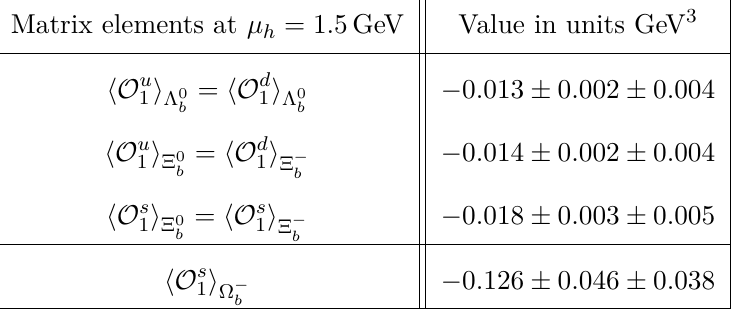
Table 4 . Numerical values for the matrix elements of the operator O q following the notation hO q